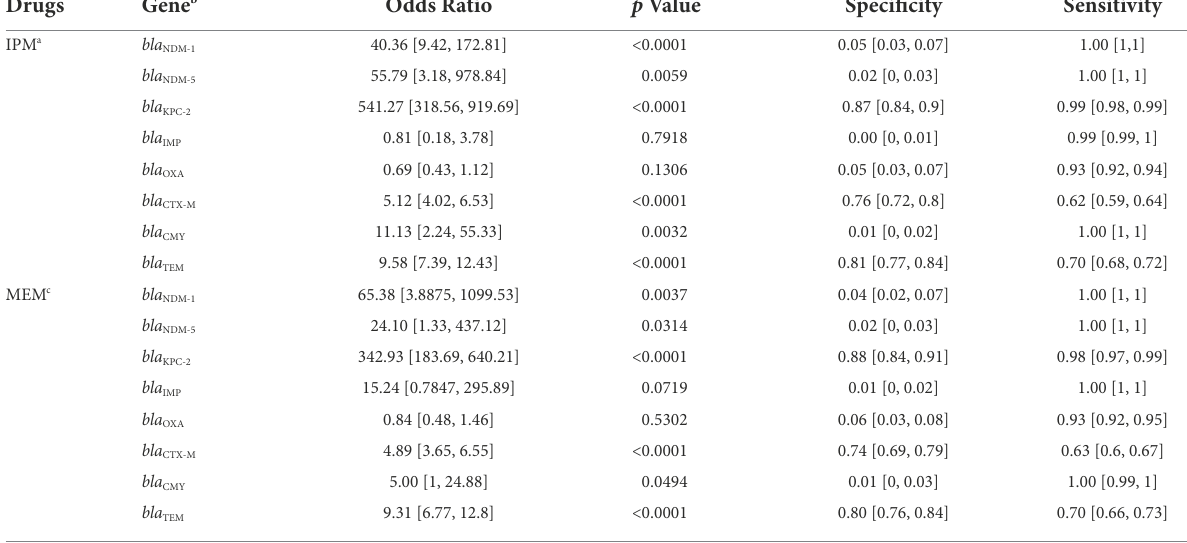
TABLE 2 Resistance phenotype explained for the known carbapenems resistance